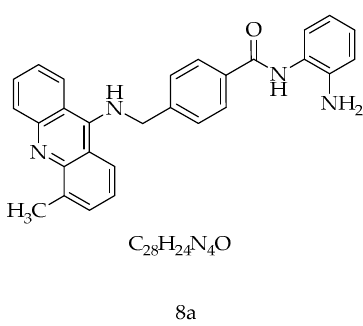
Figure 1. The structure of 8a ( N -(2-aminophenyl)-4-(((4-methylacridin-9-yl) amino) methyl) ben- zamide ) .